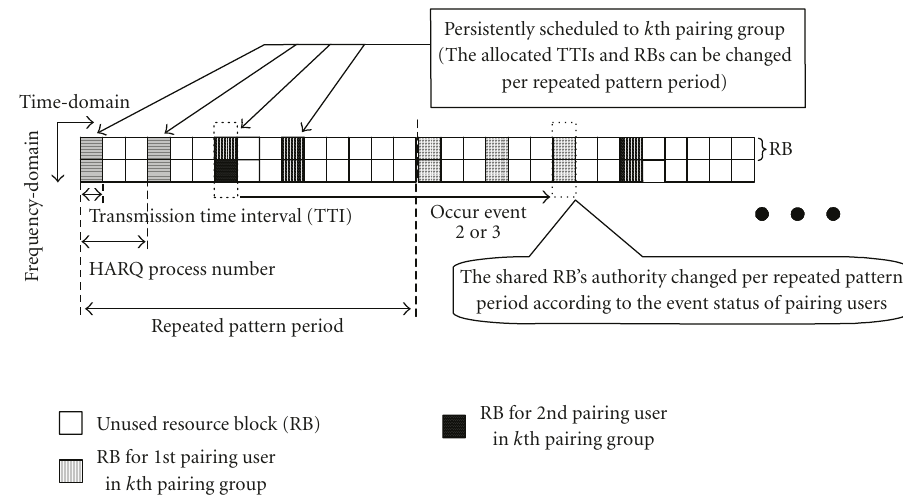
Figure 2: Resource assignment scenario with a resource sharing through user